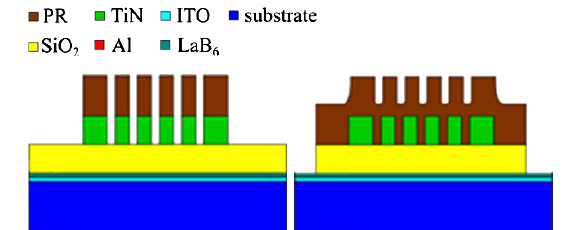
Figure 3. Schematic cross section of the detector chip after the pat- terning of a front electrode (left) and after etching the mesa (right) (Kallis et al., 2014).